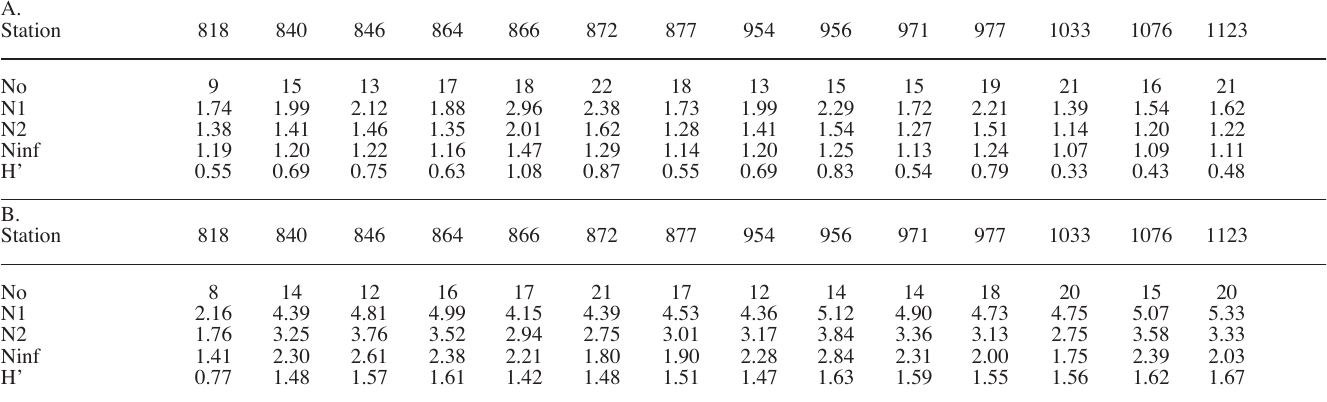
N N , N inf and Shannon-Wiener index H ’) of the meiofauna community in the Straits of 0, 1, 2,